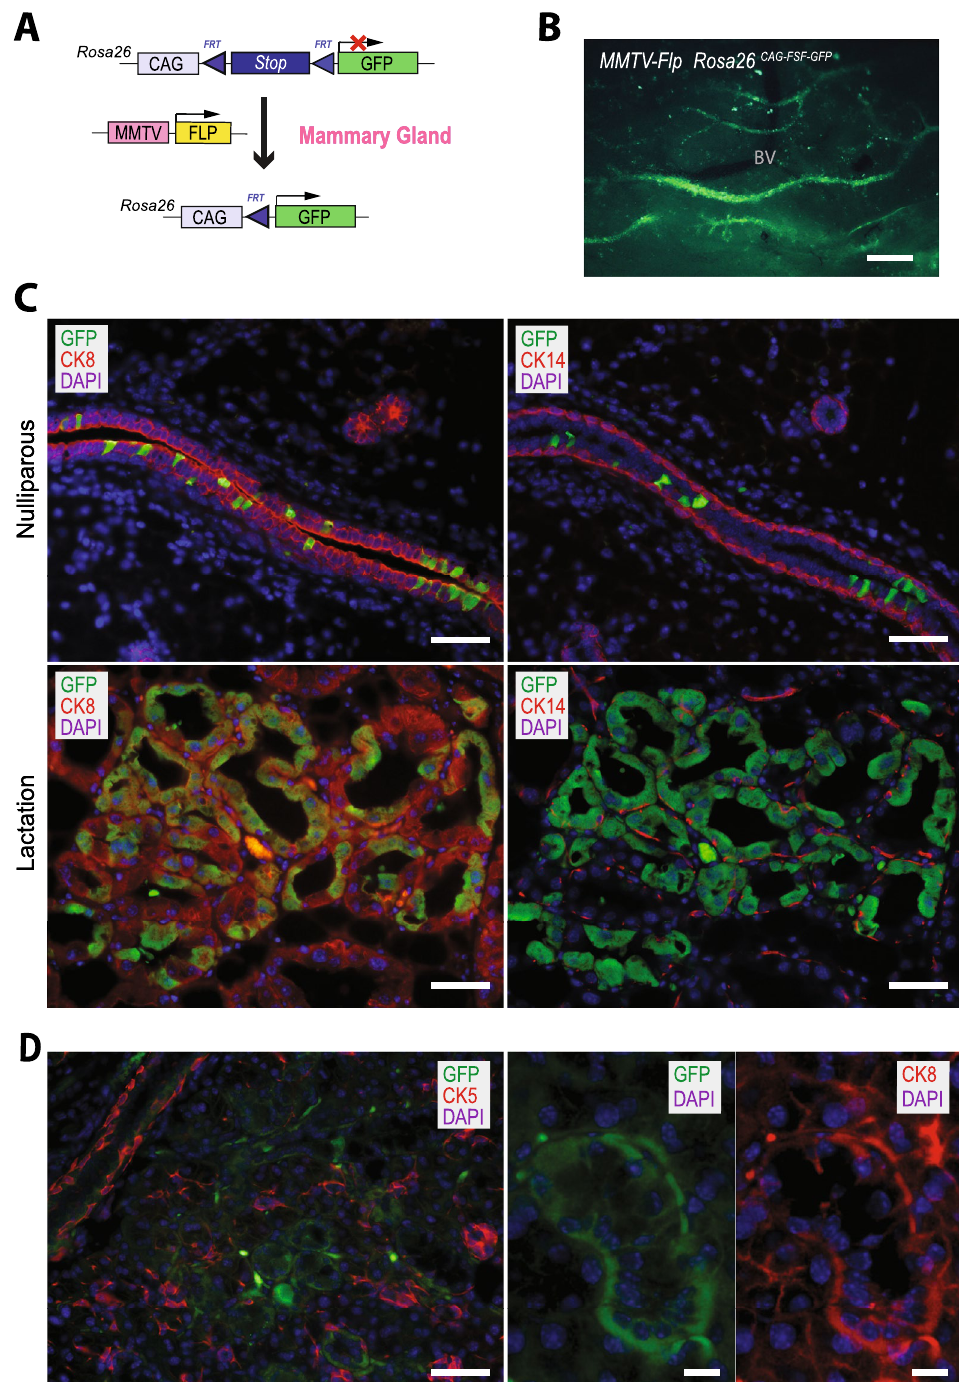
Figure 2. MMTV-Flp-induced expression of a GFP reporter allele in the luminal epithelium of the mammary gland. ( A ) Graphic illustration of the MMTV-Flp-mediated activation of the Rosa26 CAG-FSF-CreERT2 reporter allele in the mammary glands of double transgenic females. ( B ) GFP-fluorescent image of mammary gland ducts of a nulliparous MMTV-Flp Rosa26 CAG-FSF-CreERT2 double transgenic female; BV, blood vessel; bar, 1 mm. ( C ) Immunofluorescent (IF) staining of luminal cytokeratin 8 (CK8) or basal cytokeratin 14 (CK14) (both red) and GFP (green) on mammary gland sections of nulliparous (upper) and lactating (lower) double transgenic females; bars, 50 µm. ( D ) IF staining of GFP (green) in CK5 and CK8-positive epithelial cells (red) of the salivary gland; bars, 50 µm (left) and 10 µm